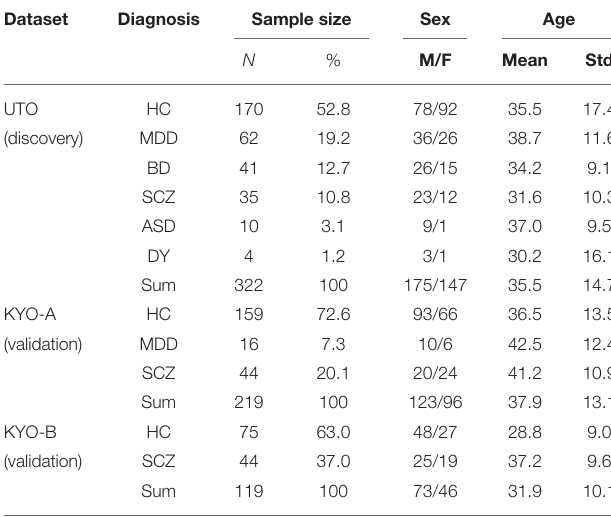
TABLE 2 | Psychiatric and demographic information of subjects in UTO (The University of Tokyo) and KYO (Kyoto University) datasets.